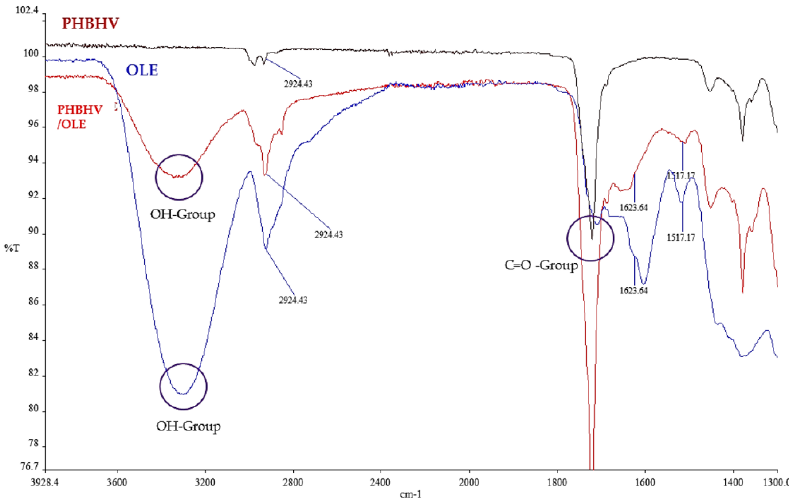
Figure 2. FT-IR ATR spectra of OLE, PHBHV, and PHBHV/OLE fibers showing characteristic bands. Y -axis is transmittance %, x -axis is wavenumbers (cm − 1 ).